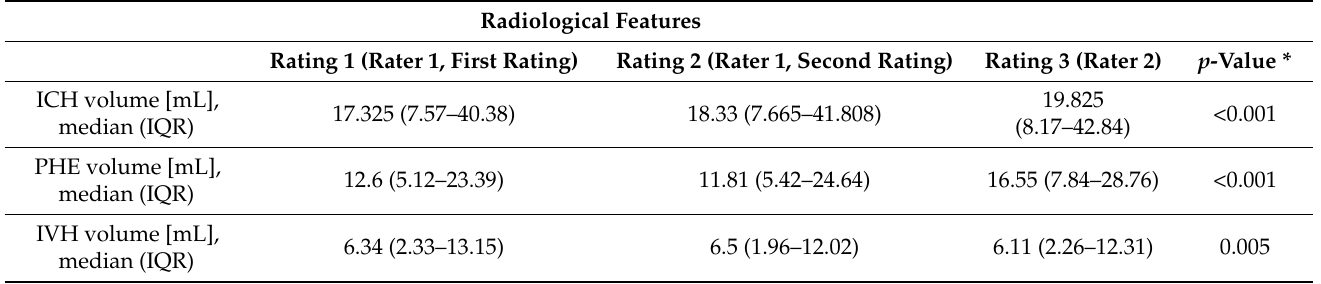
Table 2. Comparison of measured volumes.